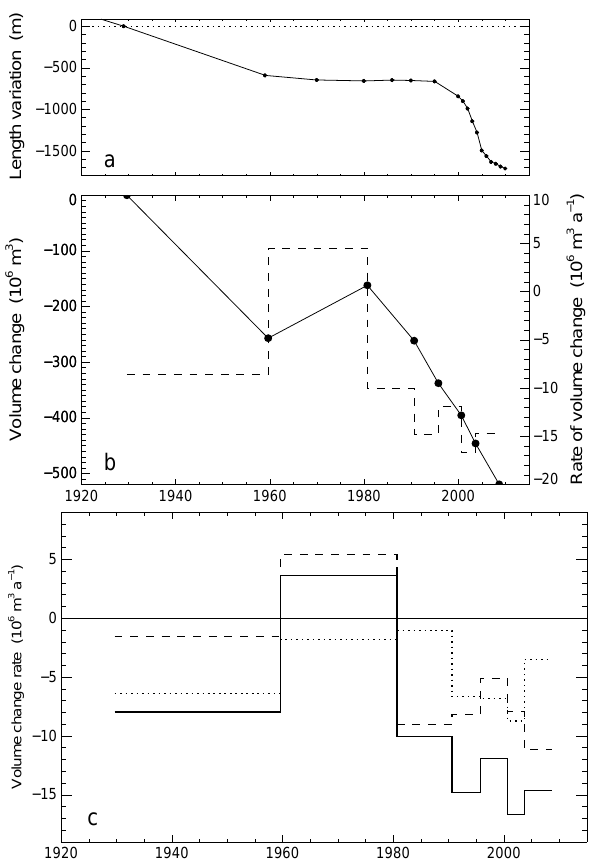
Fig. 4. Cumulative length (a) ; volume changes (solid line) and rate of volume change (dashed line) of Triftgletscher since 1929 (b) ; rates of volume change for the whole glacier (solid line), the upper part (dashed line) and the lower part (dotted line) (c)